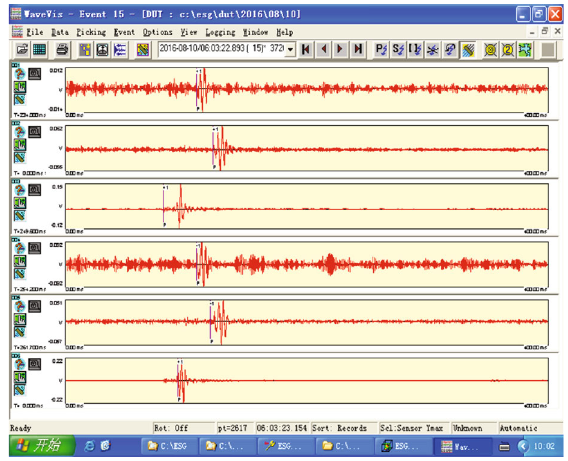
Figure 28: The waveform of sensor 1-6 on a trigger event.